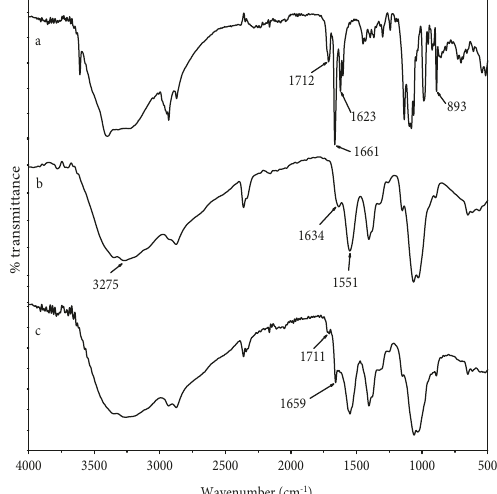
Figure 6: FTIR spectra of (a) dexamethasone, (b) CS microparticles, and (c) loaded CS